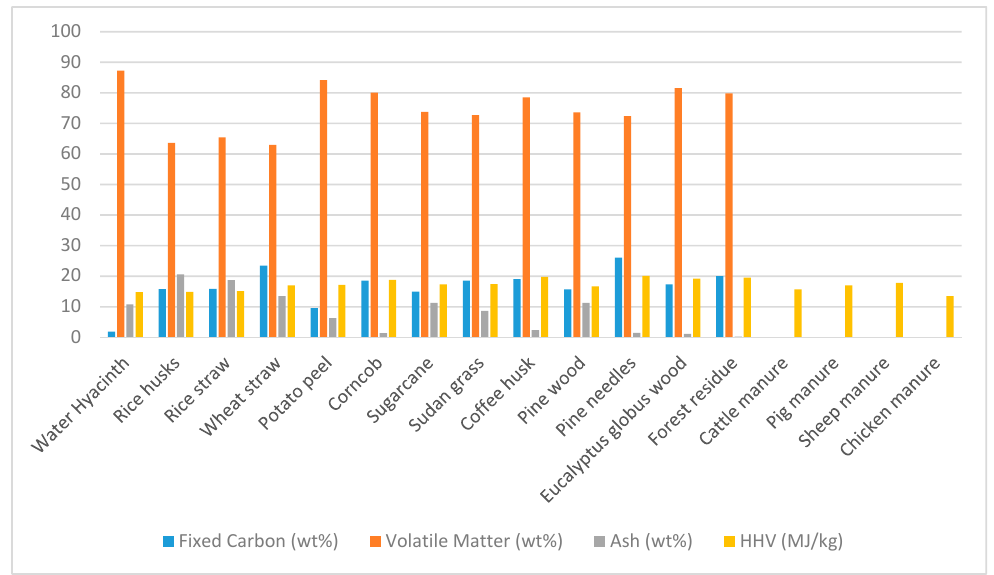
Figure 3. Characteristics of common Ugandan biomass [dry basis].